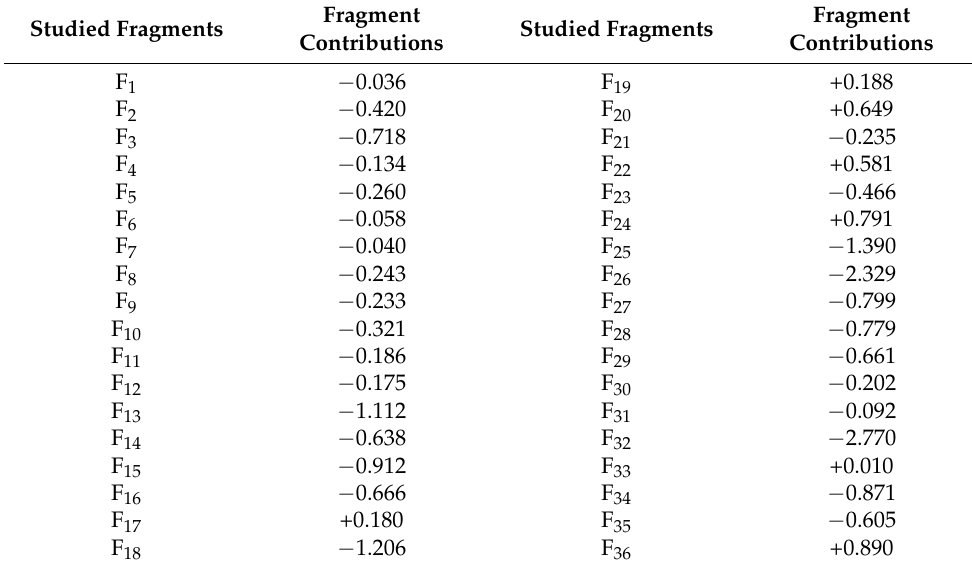
Table 2. Molecular fragments related to carcinogenic